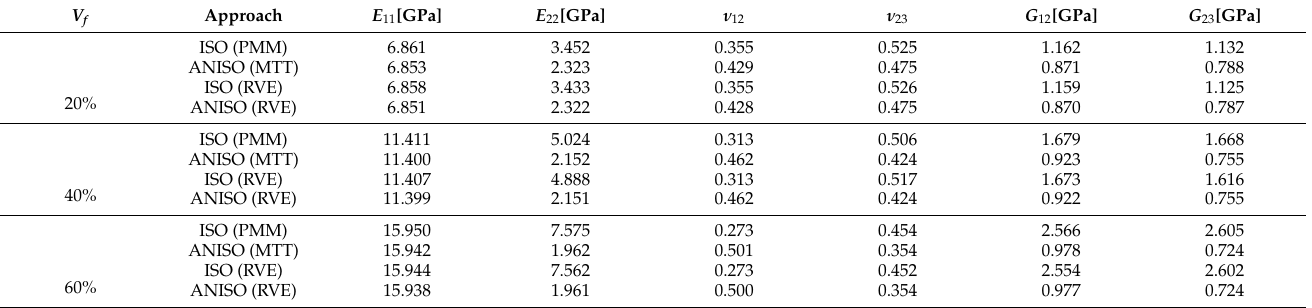
Table 2. Calculated effective properties of SFRC using the numerical RVE models and analytical